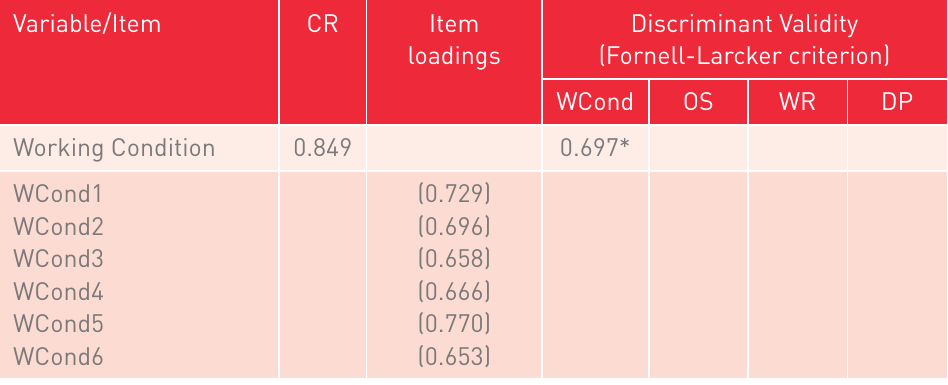
Measurement model assessment of reflective constructs